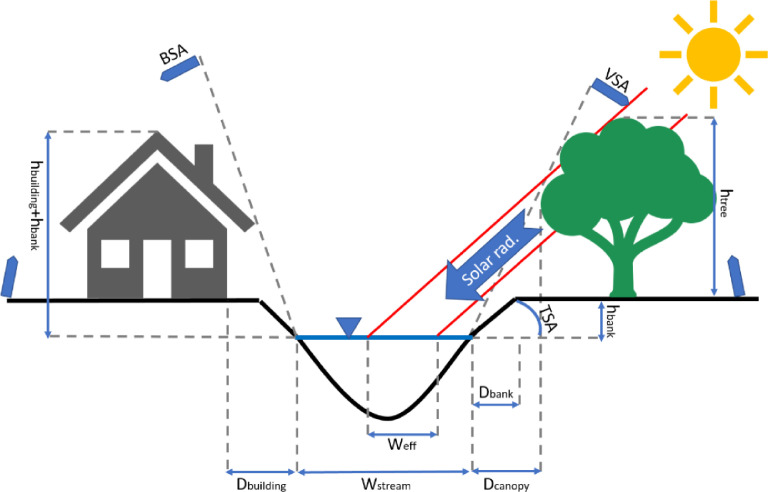
Schematic of a river cross-section where the BSA, TSA, and VSA terms are shading angles due to building, topography, and vegetation respectively. hbuilding, htree, and hbank are building, vegetation, and bank heights respectively and the Dbuilding, Dcanopy, and Dbank terms are the distances of the building, canopy, and bank respectively to the edge of the water.